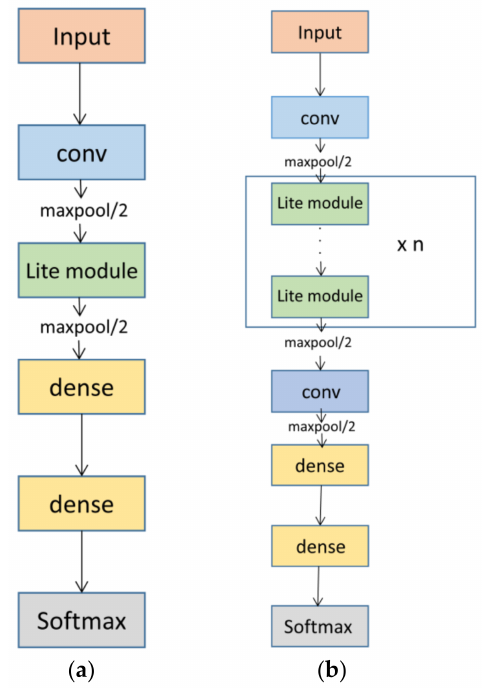
Figure 5. LiteNet Architecture: ( a ) basic LiteNet architecture; ( b ) extended LiteNet